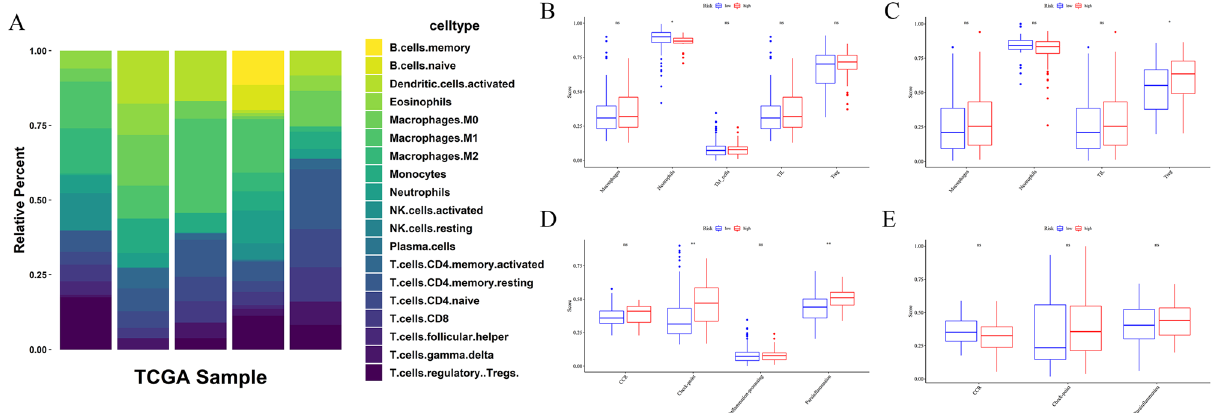
Figure 6. Tumor-infiltrating immune cell (TIC) distribution map and the single-sample gene set enrichment analysis (ssGSEA) scores between different risk groups in the TCGA and ICGC cohorts. ( A ) The bar graph shows the relative content distribution of 19 TICs of hepatocellular carcinoma in the training cohort. ( B ) Boxplots of the correlations between the scores of 5 immune cells and risk groups in TCGA. ( C ) Boxplots of the correlations between the scores of 4 immune cells and risk groups in ICGC. ( D ) Boxplots of the correlations between 4 immune-related functions and risk groups in TCGA. ( E ) Boxplots of the correlations between the scores of 3 immune cells and risk groups in ICGC. Adjusted p-values are shown as: ns, not significant (* P < 0.05; ** P <